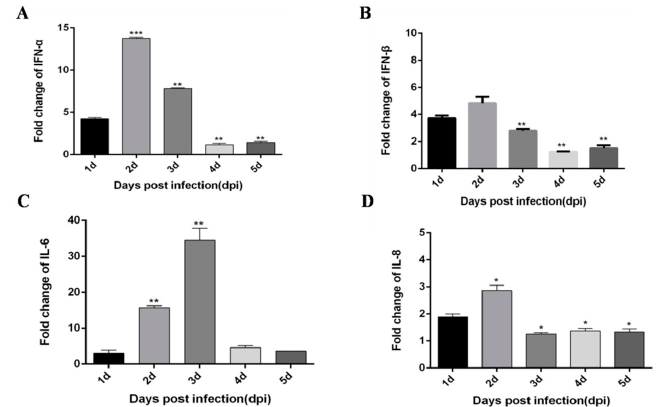
Figure 1. Duck tembusu virus (DTMUV)-infected ducks effectively up-regulate IFN- α , IFN- β , IL-6, IL-8 expression in the thymus. Each young specific pathogen-free (SPF) duck was challenged by intramuscular inoculation with DTMUV. ( A – D ) Thymus tissues of mock- and DTMUV-infected ducklings were collected at the indicated time points for examination of IFN- α ( A ), IFN- β ( B ), IL-6 ( C ), and IL-8 ( D ) mRNA expression using qRT-PCR. The average levels from three independent experiments are plotted. The error bars represent the SEs. * P < 0.05, ** P < 0.01. Viruses 2020 , 12 , 94